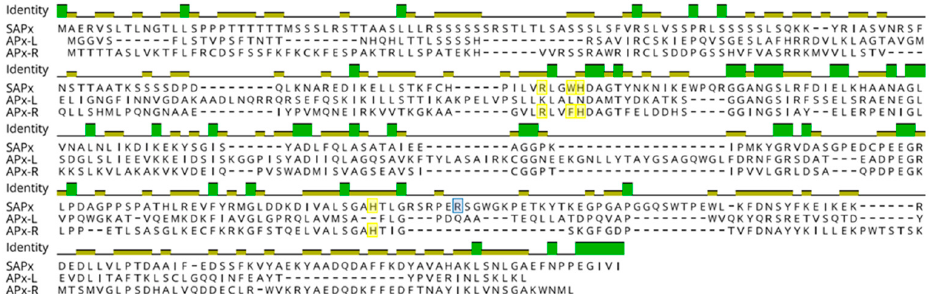
Figure 2. Protein sequence alignment of Arabidopsis stromal APX (SAPx; At4g08390), APX-R (At4g32320), and APX-L (At4g09010). Positions related to APX catalytic activity are highlighted in yellow and to ascorbate binding, in blue.